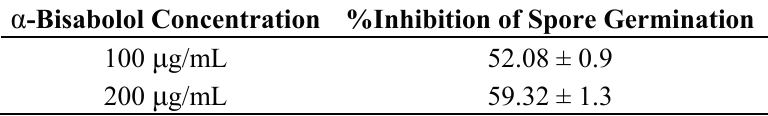
Figure 2. Effect of time and spore density on percent reduction of Resazurin. The highest reduction occurred after 120 h of incubation with a spore density of 10 5 spores. Table 3. Percent inhibition values on spore